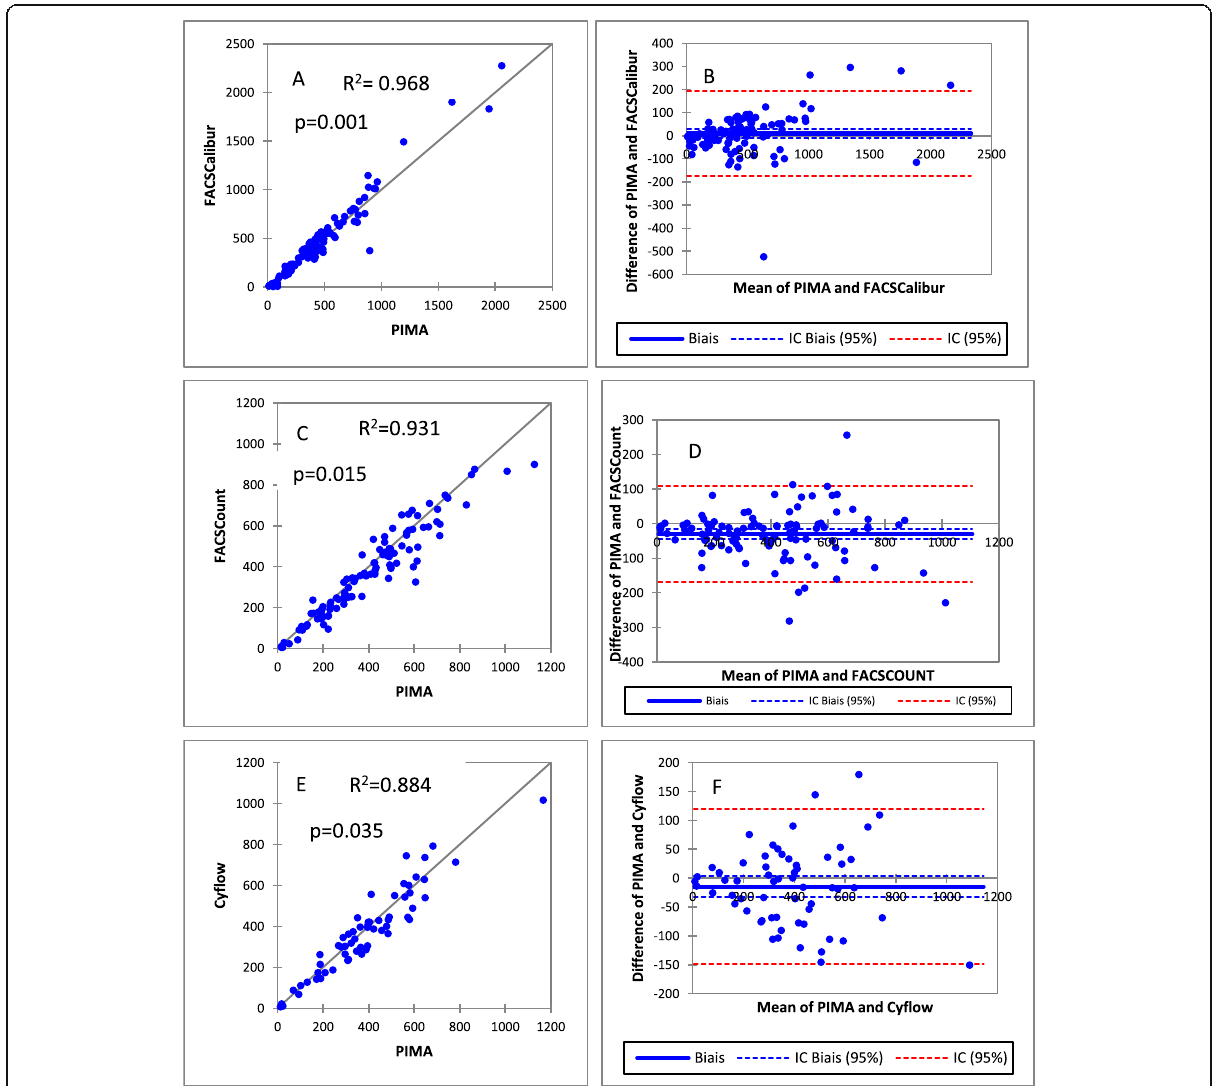
Fig. 1 Linear regression analysis and Bland-Altman analysis using whole blood sample of absolute CD4+ T lymphocyte counts between PIMA and FACSCalibur ( a and b ), PIMA and FACSCount ( c and d ), and PIMA and CyFlow ( e and f )